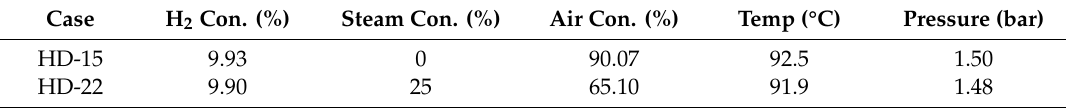
Figure 3. THAI facility [12]. Table 2. Initial conditions of the THAI HD-15 and HD-22 Test [12].